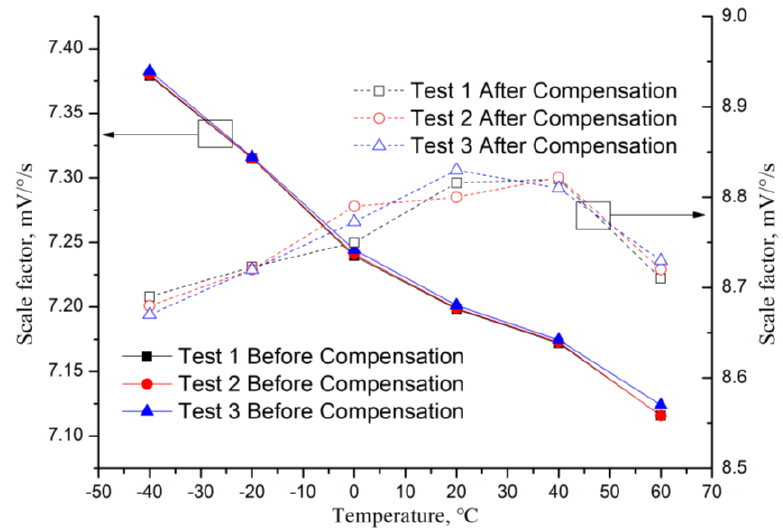
Figure 10. MEMS gyroscope scale factor before and after temperature compensation results.